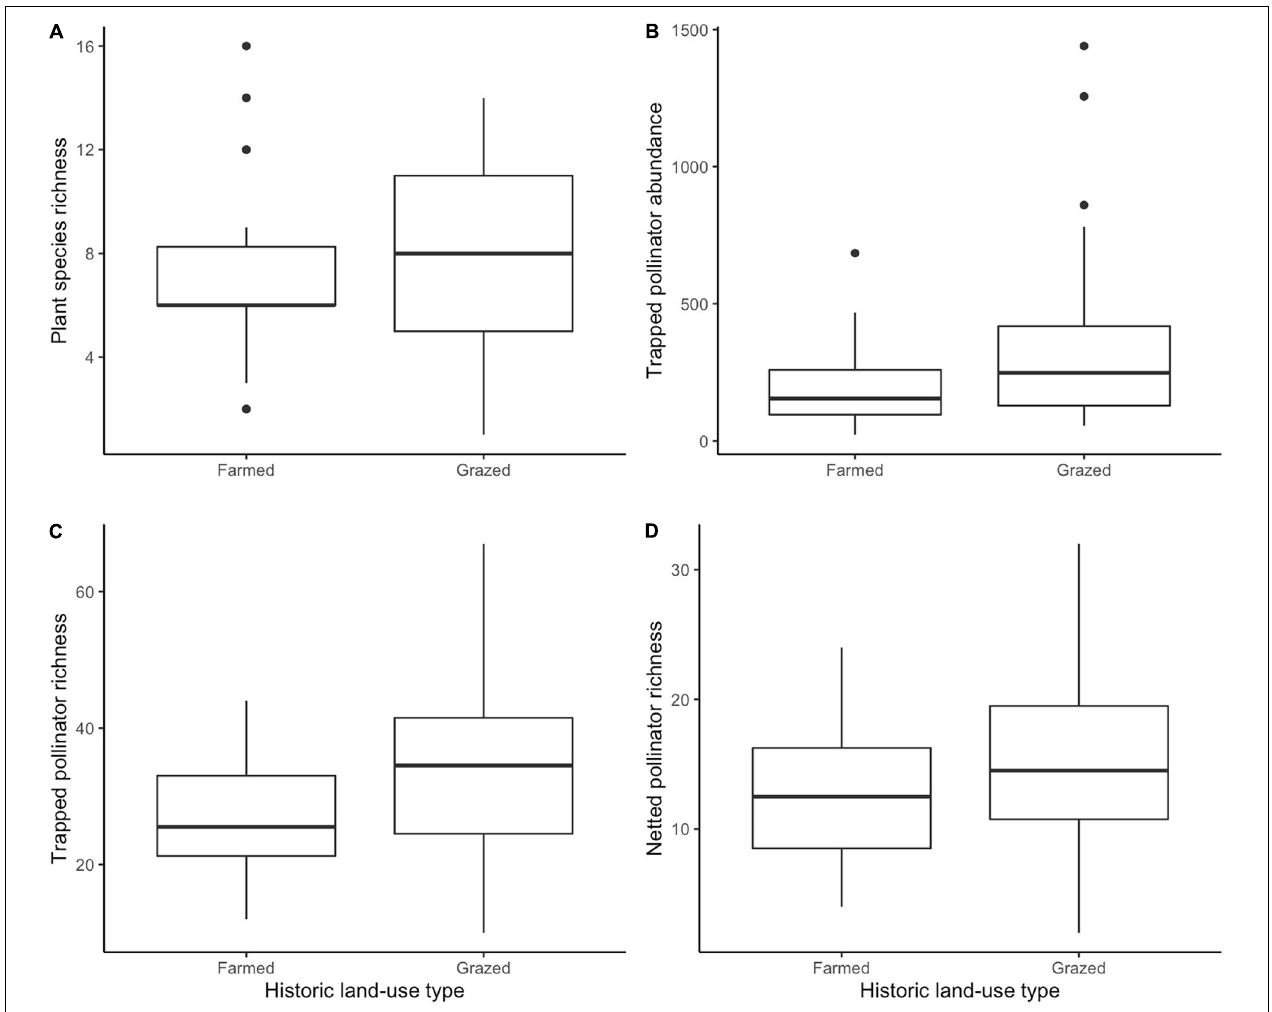
FIGURE 2 | Boxplots displaying historic land-use as a significant predictor of plant species richness (A) , trapped pollinator abundance (B) , trapped pollinator richness (C) , and netted pollinator richness (D) .